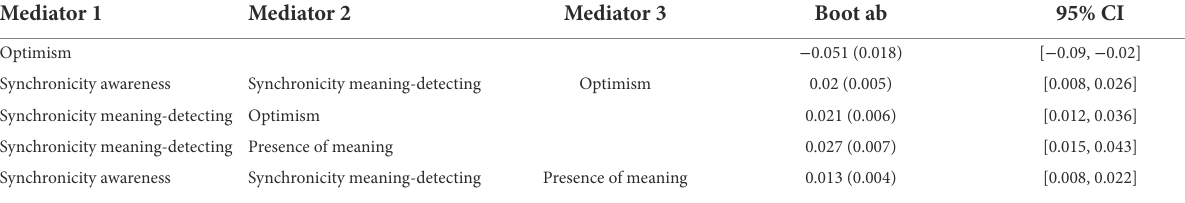
TABLE 6 Indirect effects from search for meaning on life satisfaction testing both parallel and sequential mediation